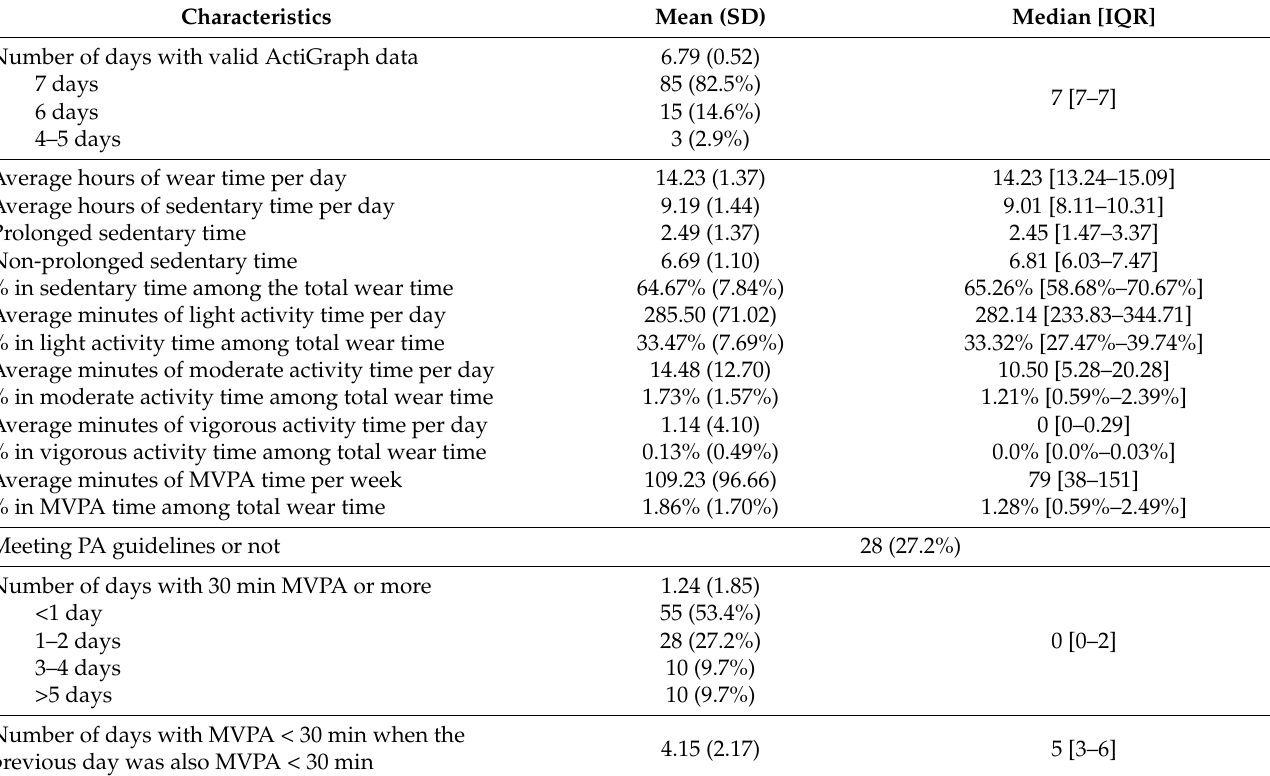
Table 3. Characteristics of the Actigraph data among Chinese immigrants in the US with prior GDM (n =